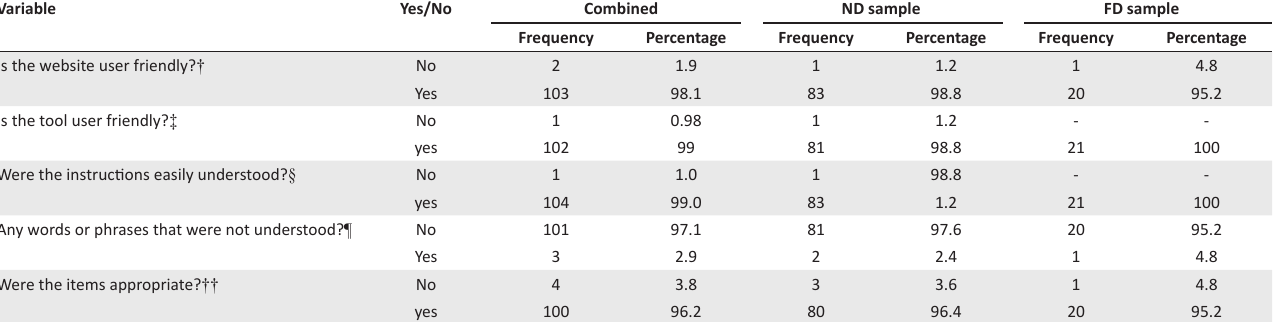
TABLE 7: Tool and website feedback for combined, ND and FD samples.